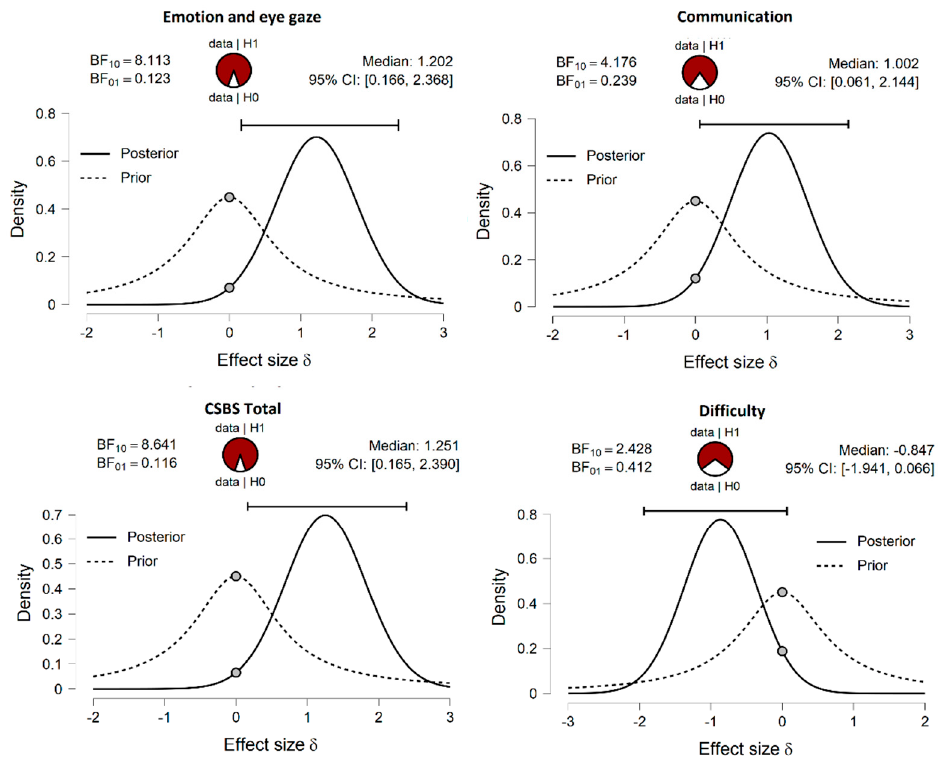
Figure 1. Bayesian inferential plots on prior knowledge and posterior knowledge, to indicate evidence to support the H1 over H0 under the Bayes factor notation (BF 10